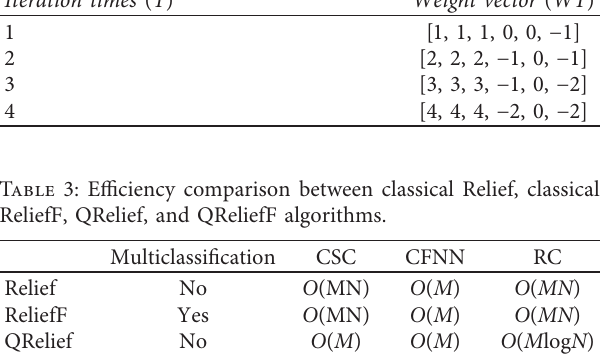
Table 2: The updated result of WT. Iteration times ( T )